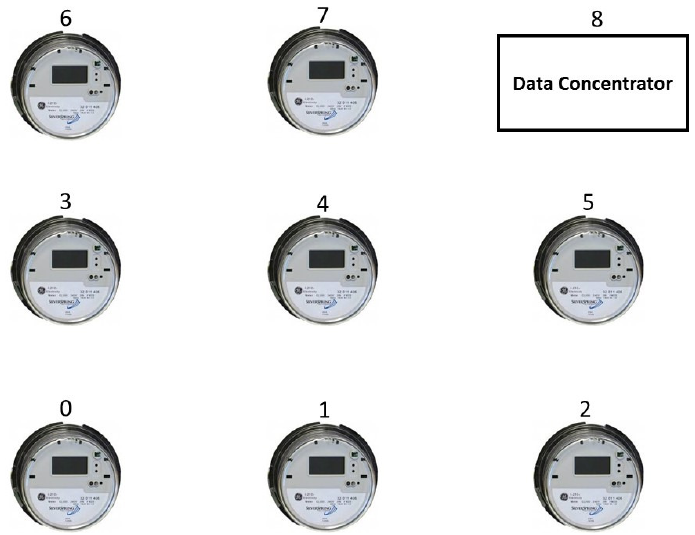
Figure 2. A representation of smart meter nodes in a 3 by 3 grid WMN-based